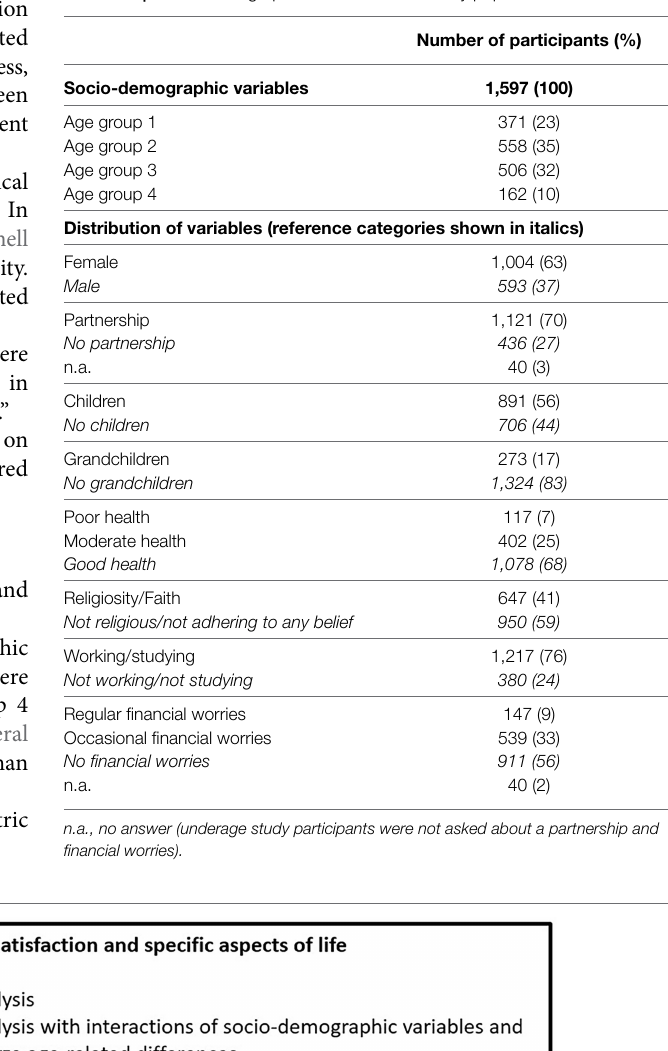
TABLE 1 | Socio-demographic variables of the study